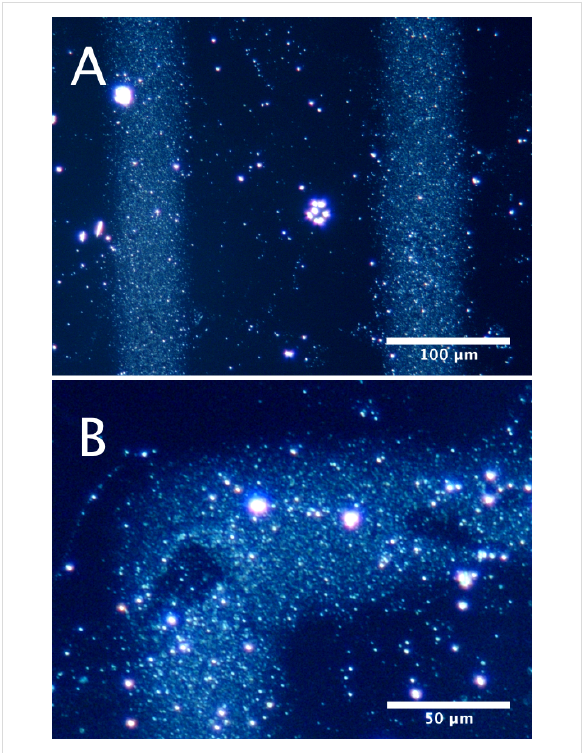
Figure 2: A) Representative dark-field image of pattern printed using rGO–Pt ink. B) Enlarged detail of the “elbow” portion of a printed pattern, showing some defects. Bright white spots are imperfections in the glass and/or